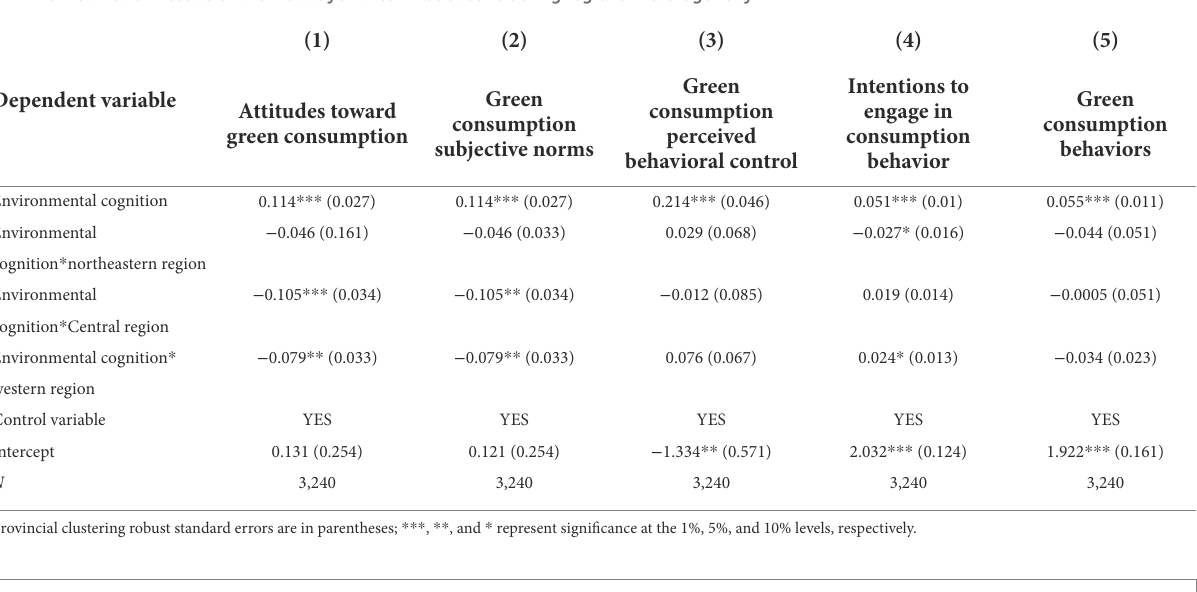
TABLE 8 Estimation results of the multilayer linear model considering regional heterogeneity.